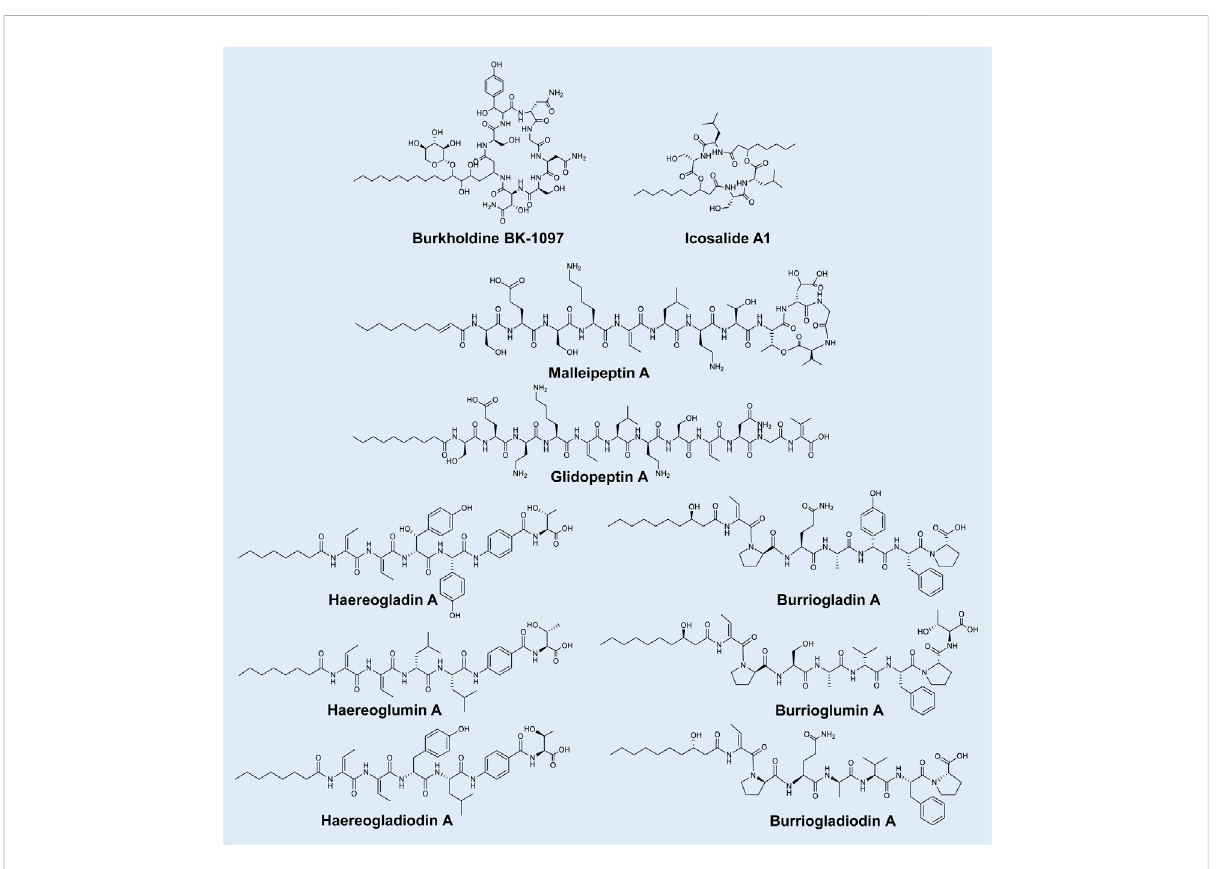
FIGURE 2 Representative lipopeptides produced by Burkholderia species. The structural information was obtained from the PubChem database (https:// pubchem.ncbi.nlm.nih.gov/), as well as thecorresponding references provided in-text. The structures weresubsequently drawn in ChemDraw Ultra version